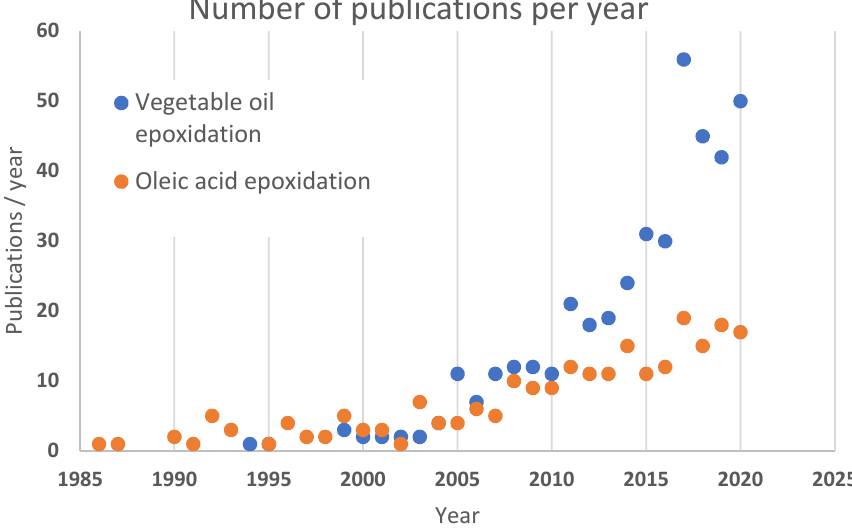
Figure 4. Number of publications per year with the search words vegetable oil epoxidation and oleic acid epoxidation, obtained from webofscience.com (some are overlapping).